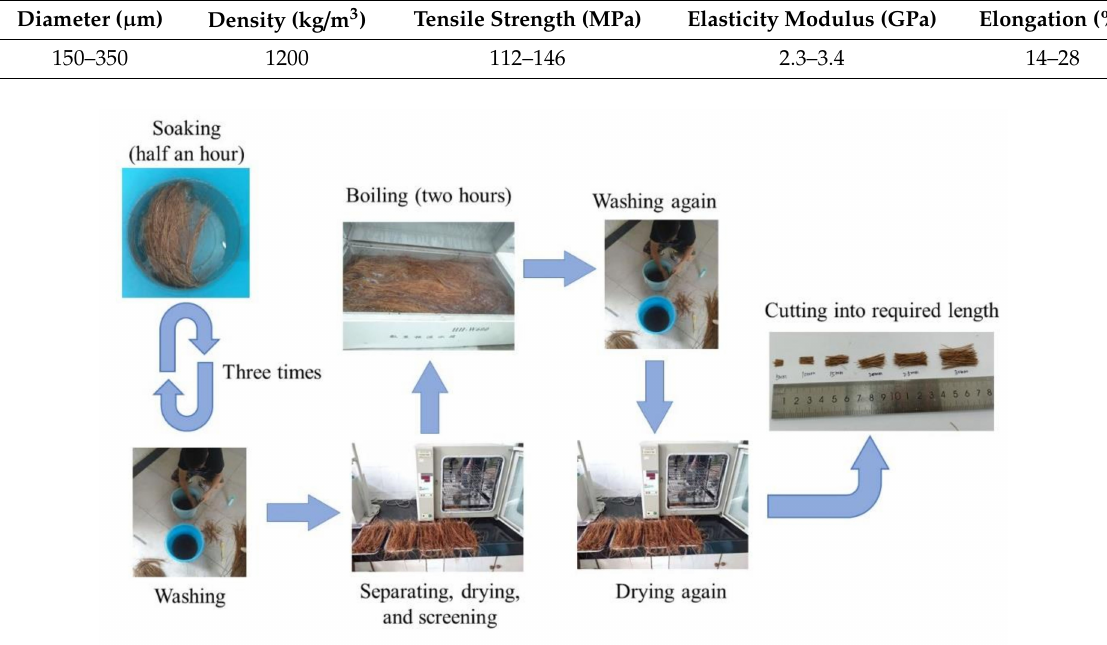
Table 4. Physical properties of coir fiber (CF).